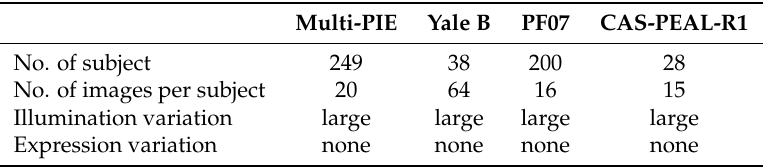
Table 1. Characteristics of each